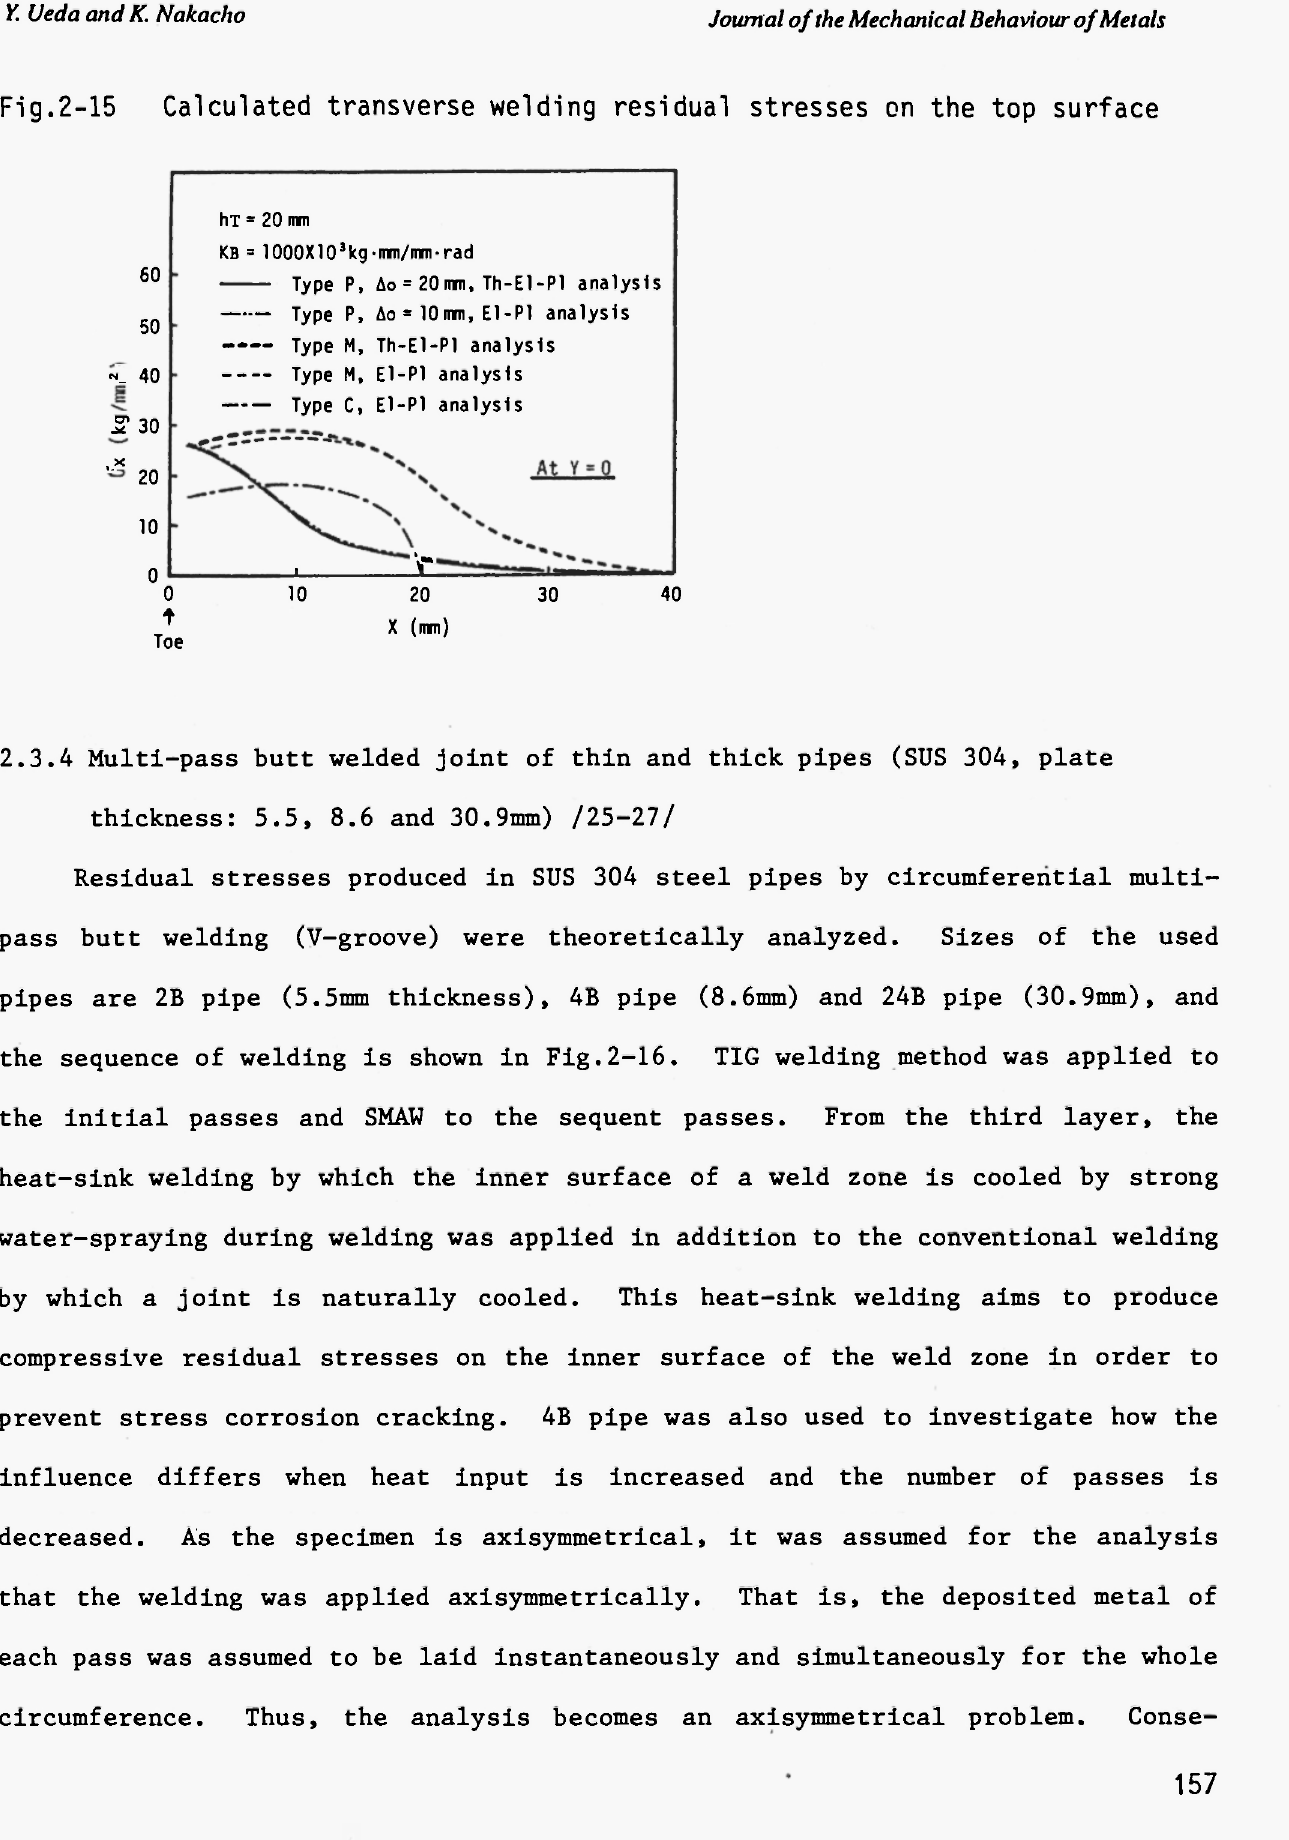
Fig.2-15 Calculated transverse welding residual stresses on the top